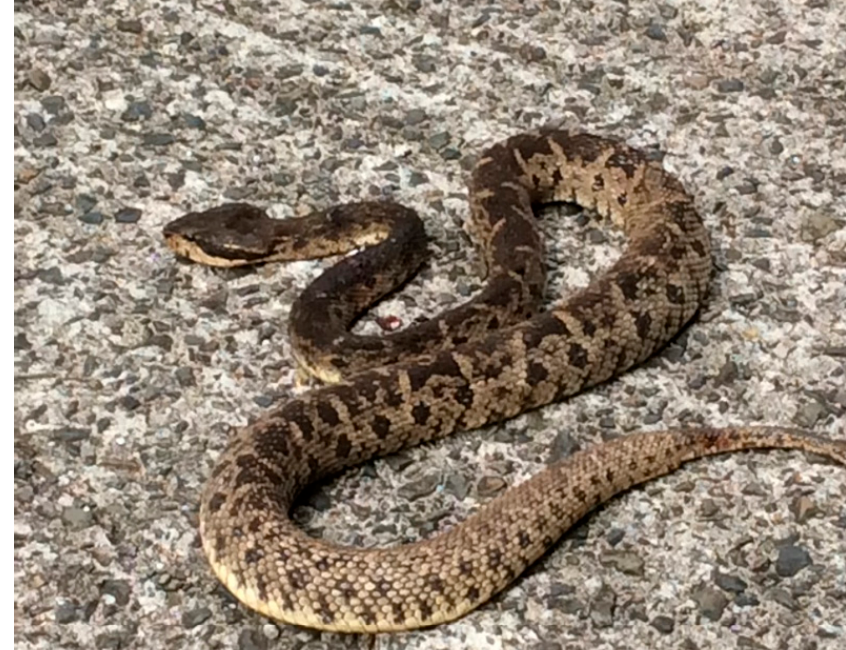
Figure 1. Bothrops lanceolatus from Martinique, known as trigonocéphale or fer ‐ de ‐ lance is one the most dangerous venomous snakes in the Caribbean. (Photo courtesy of Mr. Michel Tanasi, a member of the snake working group).